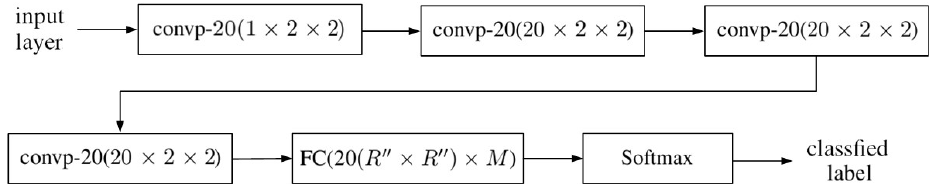
Figure 10. Schematic of the